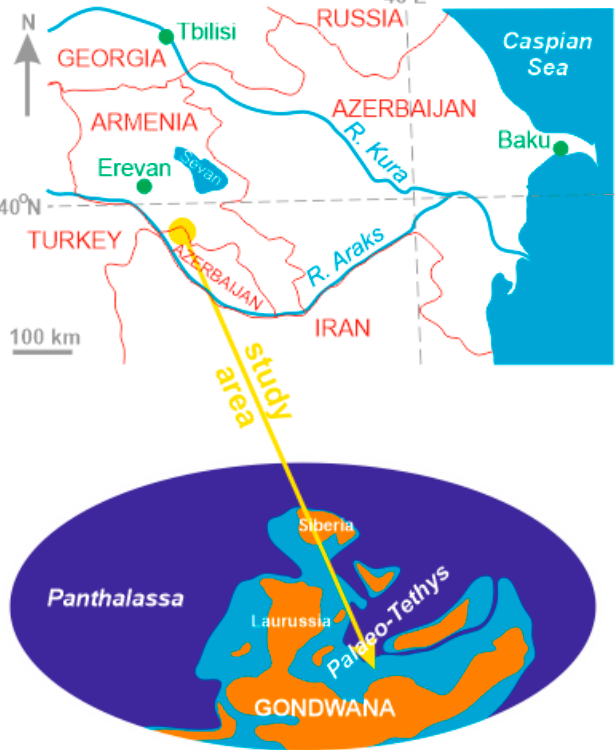
Figure 1. Present and Famennian location of the study area (created by the authors; the palaeogeographical reconstruction follows the contours shown by [24]).